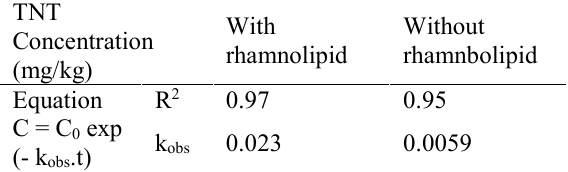
Table 2. Reductive degradation of TNT.